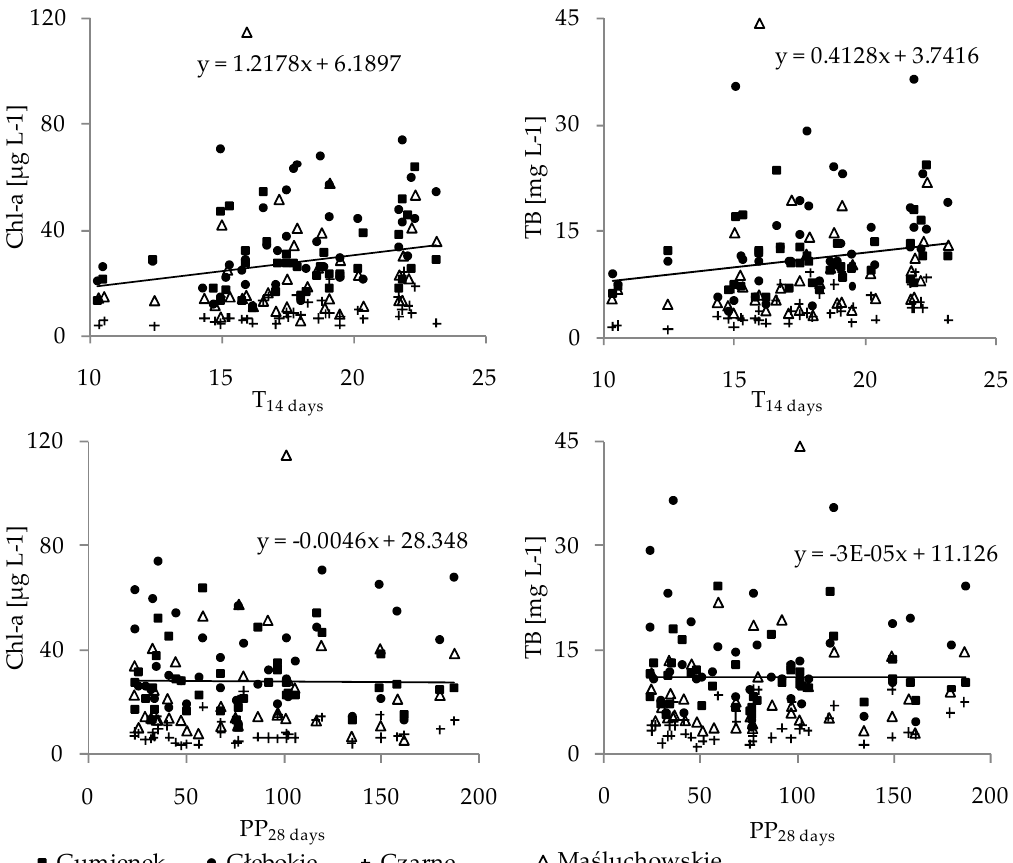
Figure 3. Relationship between the concentration of chlorophyll a (Chl- a ) and the phytoplankton biomass (TB) and the mean air temperature (T 14 days ; upper panel) and total precipitation (PP 28 days ; lower panel) in the studied lakes during the investigation period (2010–2014).